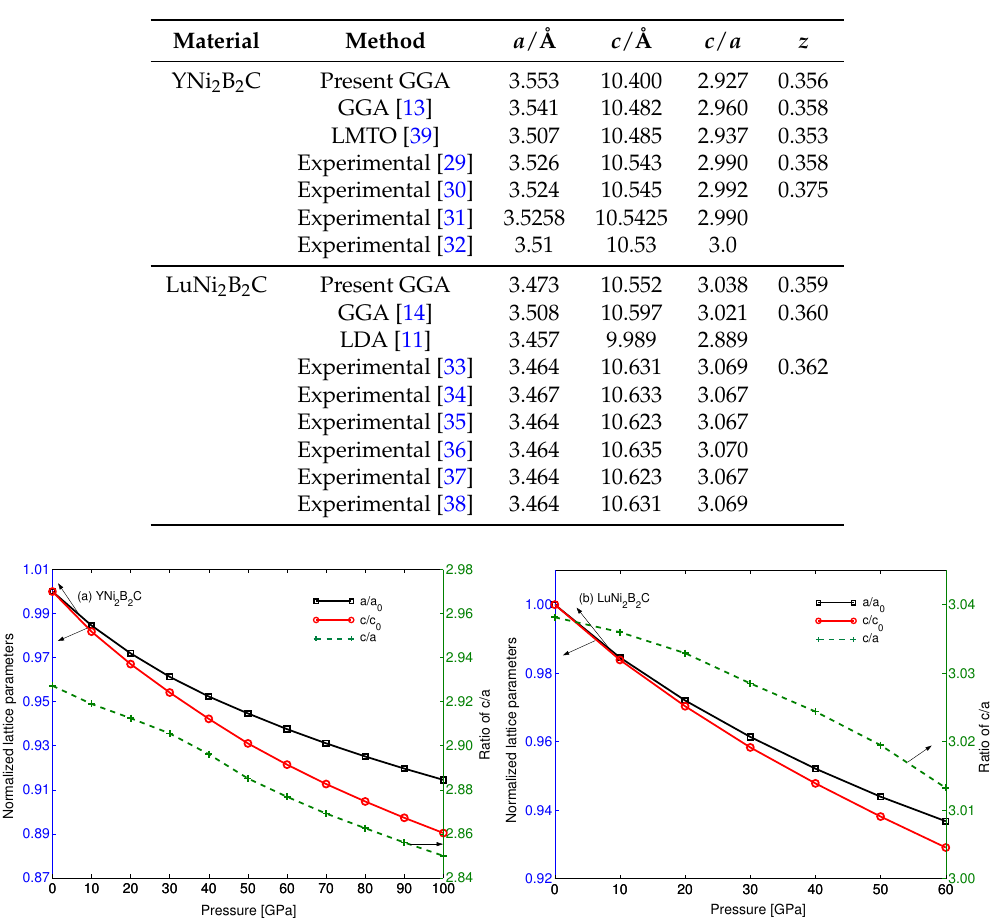
Table 1. Comparison of the calculated lattice parameters (Å) for RNi 2 B 2 C (R=Y, Lu) at p = 0 GPa with the previous theoretical results and experimental data.